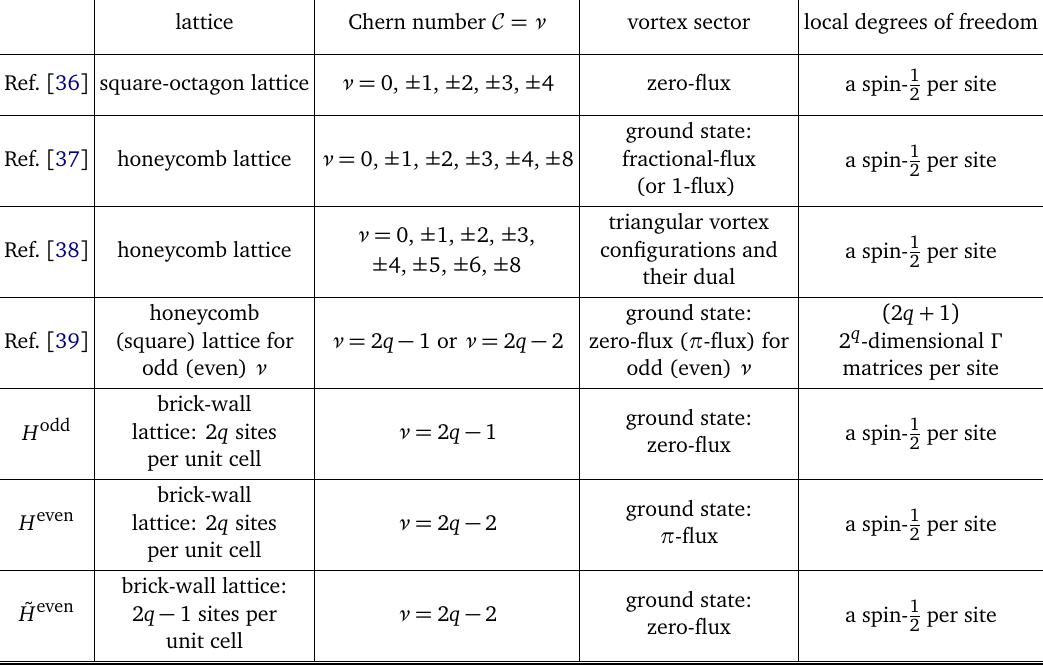
Table 1: xactly solvable models toward Kitaev’s sixteen-fold way: comparison between our models ( H odd , H even , and ˜ H even ) and those presented in previous works [ 36–39 ]